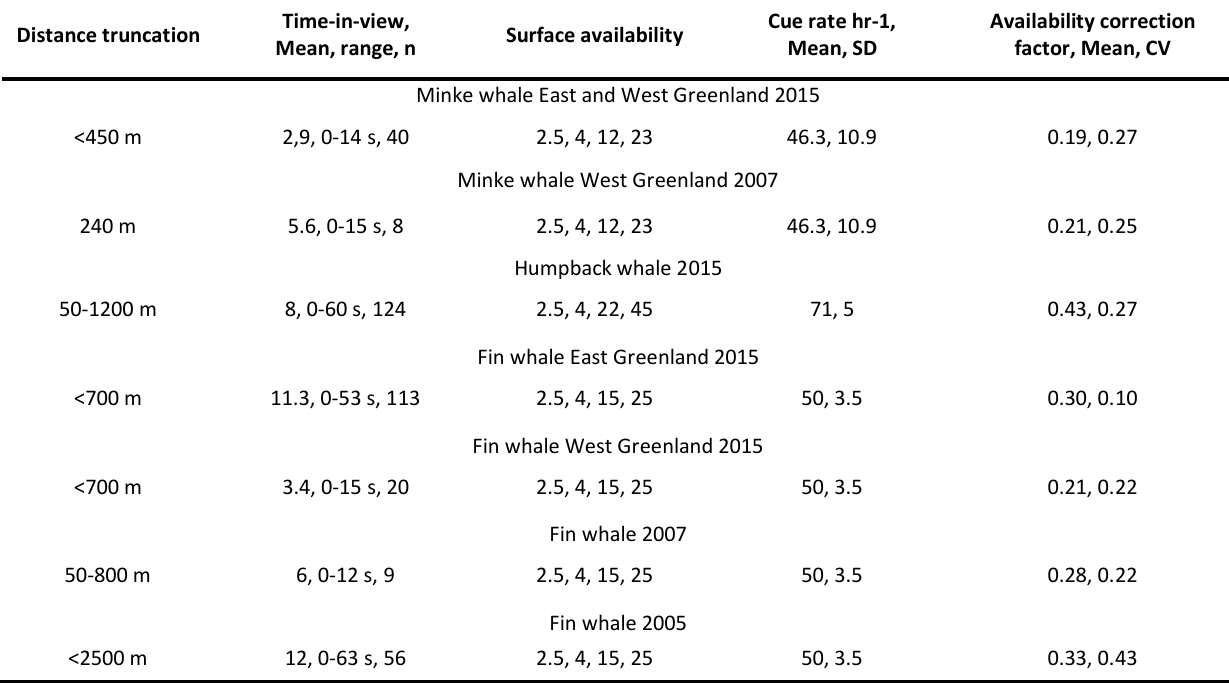
Table 5. Development of availability correction factors for minke, fin and humpback whales for different distance truncations for detections from 0 to 2 m depth. The cue rates were obtained from Heide-Jørgensen and Simon (2007). The beta distribution of the surface availability (see Table 1) was skewed to the right and restricted to avoid unrealistically low (i.e.<12%) surfacing times. A Kolomogorov-Smirnov test detected a significant difference for the time- in-view distributions of fin whales from East and West Greenland in 2015 (p=0.013) but no difference was found for humpback whales (p=0.872) or minke whales (p=0.604) for the same